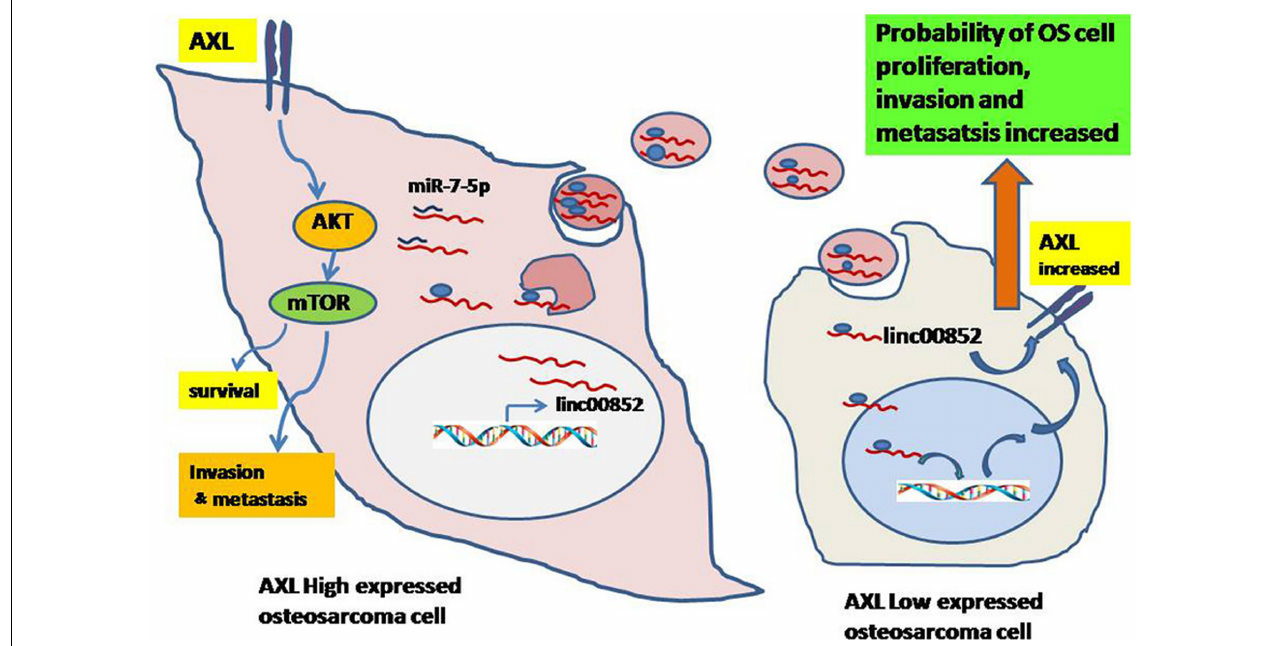
FIGURE 2 | Schematic diagram of exosomal linc00852 function in the growth and progression of osteosarcoma. Osteosarcoma cells with high AXL expression secrete exosomal linc00852 and then are transmitted to cells with low AXL expression. Most linc00852 transfer to receptor cells’ nucleus, increase AXL expression to activate AKT pathway and promote osteosarcoma progression with unknown mechanisms. Meanwhile, a few linc00852 play a role as ceRNA for miR-7-5p to increase expression of AXL in cytoplasm. Reprinted from Li Q. et al. (2020).